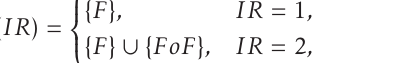
Figure 1. The figure shows a possible profile configuration for two users x and y , who disclose k out of the m possible attributes. The clear rectangles represent the disclosed attributes while the shaded rectangles represent withheld